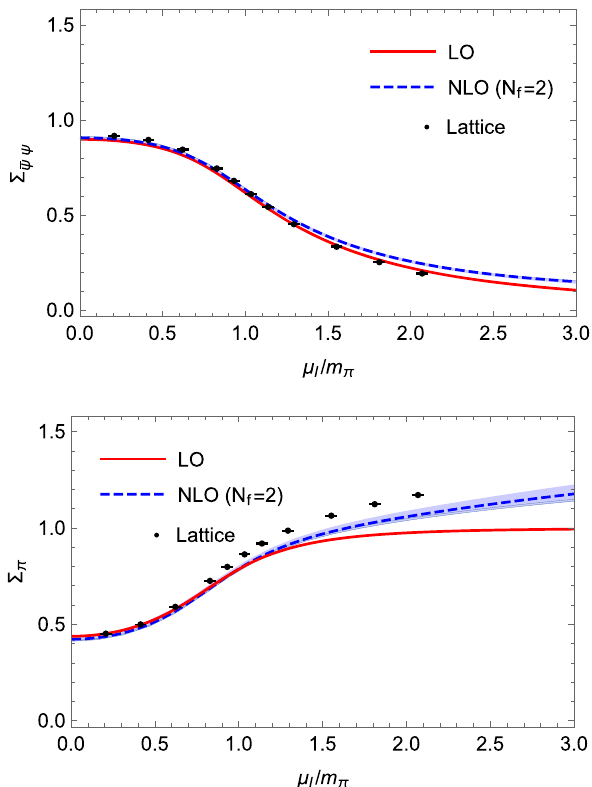
Fig. 4 Top: Quark condensate deviation from the normal vacuum value, Σ ¯ ψψ , at T = 0. Bottom: Pion condensate deviation from the nor- mal vacuum value (which is 0), Σ π , at T = 0 and j = 0 . 0129263 m π . See text in Sect. 5.4 for